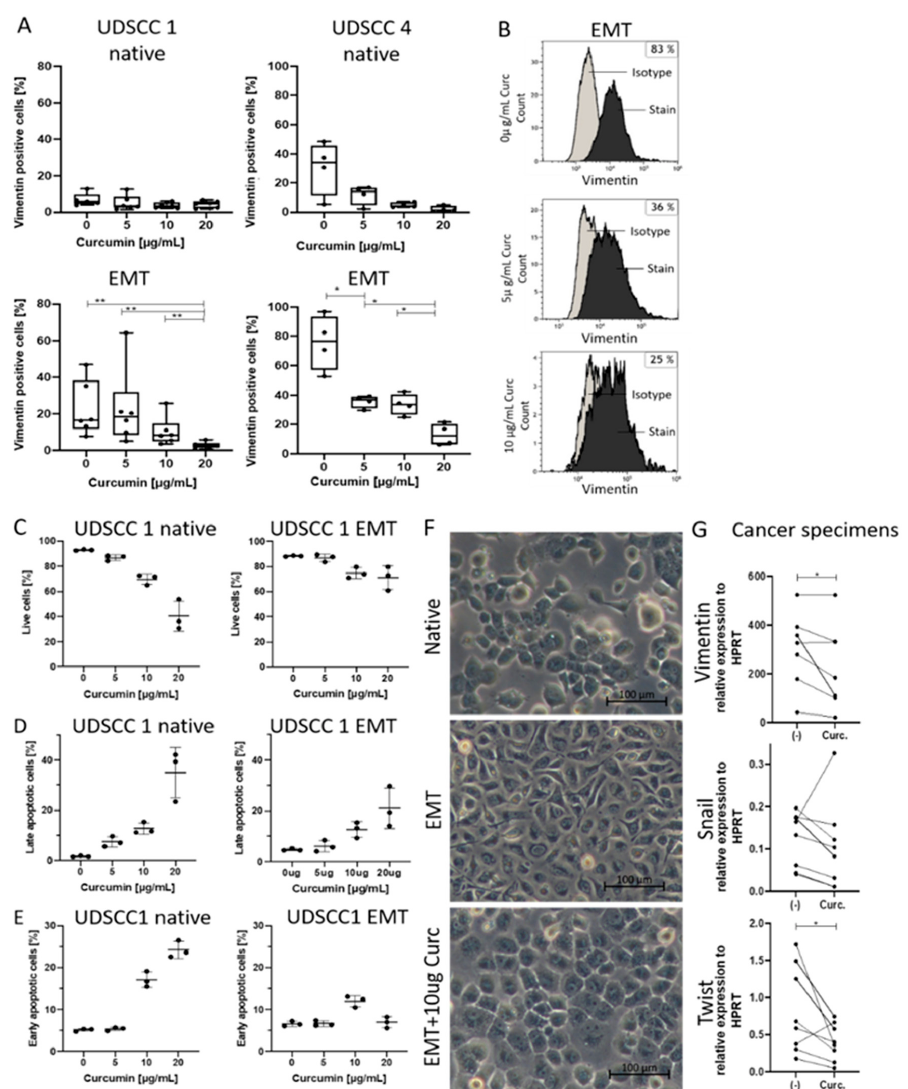
Figure 2. ( A – E ) Native and EMT-induced UDSCC1 or UDSCC4 cells were treated with indicated concentrations of curcumin (0, 5, 10, or 20 µ g/mL) for 48 h. Then, vimentin expression was analyzed by flow cytometry ( A , B ), and apoptosis was assessed by annexin/propidium iodide (PI) assay ( C – E ). ( A ) EMT-induced cell lines showed significantly decreased vimentin expression with increased concentrations of curcumin; n = 4 (UDSCC4 EMT), n = 6 (UDSCC1 EMT and UDSCC4 native), n = 7 (UDSCC1). Bars represent minimum to maximum, with a line at the mean. ( B ) Representative flow cytometry histograms depicting vimentin expression of EMT-induced UDSCC4 cells after incubation with curcumin. ( C ) The amount of live UDSCC1 cells was especially reduced for native cells with increased concentrations of curcumin. ( D ) Late UDSCC1 apoptotic cells were detected for native cells with 20 µ g/mL curcumin; effects on EMT-induced cells were less prominent. ( E ) The number of early apoptotic cells was higher with increased curcumin concentrations, especially with 20 µ g/mL. Effects were more pronounced for native cells. n = 3. Bars represent minimum to maximum with a line at the median. ( F ) Native UDSCC cells showed typical epithelial characteristics such as rounded cell bodies (top), while EMT-induced cells showed mesenchymal remodeling with its signifying protrusions (middle). We observed that EMT-induced cells incubated with 10 µ g/mL curcumin (Curc.) were able to convert mesenchymal characteristics into epithelial ones (bottom). ( G ) Evaluation of mesenchymal markers (Vim/Snail/Twist) in cancer specimens by qRT-PCR after incubation with the negative control (-) or 10 µ g/mL curcumin (Curc.) for 24 h. mRNA levels are shown as relative expression to the normalization control HPRT. n = 9, each dot represents an individual tumor sample. P -values in ( A ) and ( G ) were determined with the Mann–Whitney test, with * p < 0.05, ** p <